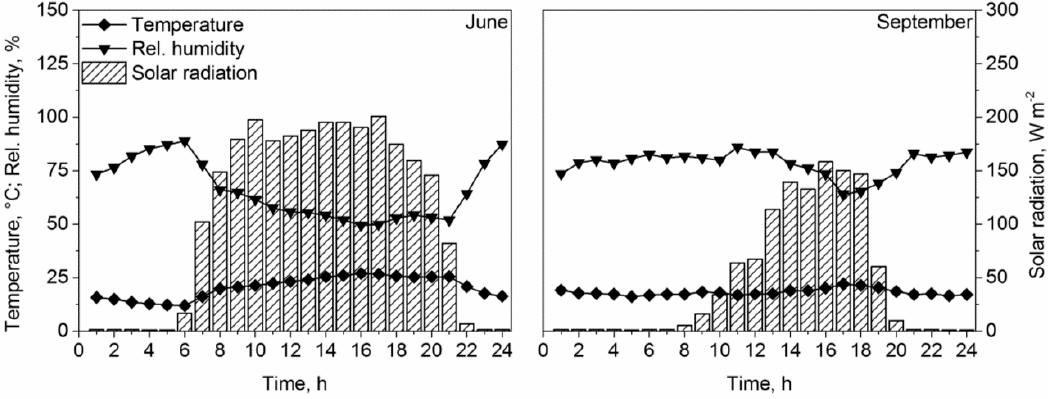
Figure 2. Ambient temperature, rel. humidity and solar radiation on an exemplary day; (left) in June for variants using the waste-heat of the combined heat and power unit (S-CHP); (right) in September for variants using additionally exhaust air of a micro turbine (S-CHP-MT).